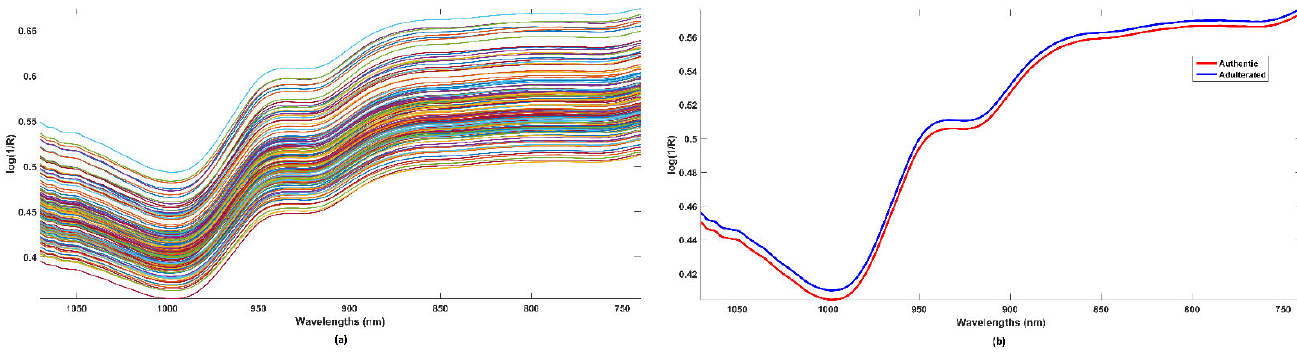
Figure 1. NIR spectra ( a ) raw spectra of all the investigated samples, ( b ) mean spectra of authentic (red line) and adulterated samples (blue